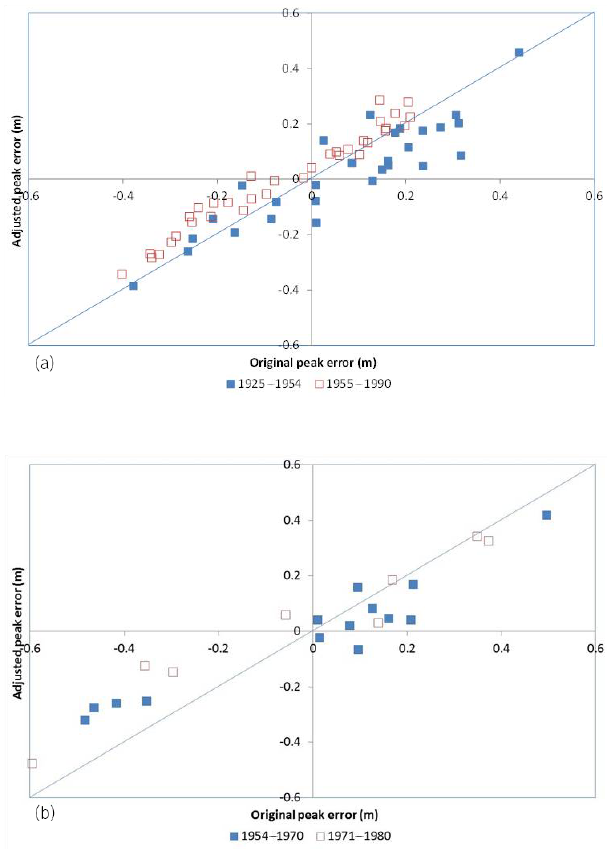
Figure 6. Illustration of the effect of including fixed parameter re- gression relationships with DMI and NINO34 for the model residu- als on errors in annual maximum levels at lead times of (a) 5 months for Lake Victoria and (b) 4 months for Lake Malawi. Climatologi- cal rainfall inputs were used and a one-to-one trend line is shown as a guide.